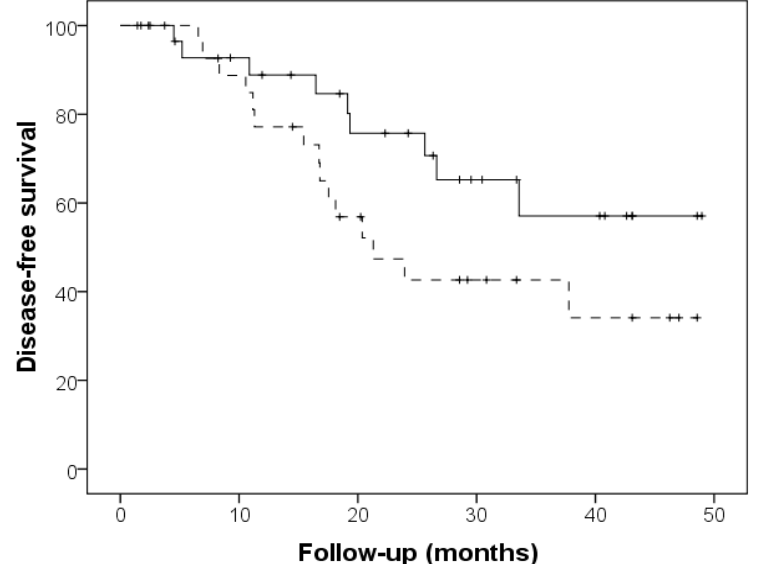
Figure 2. Dialysis-free survival in the probiotics group (continuous line) and placebo group (dashed line) (log rank p = 0.080).